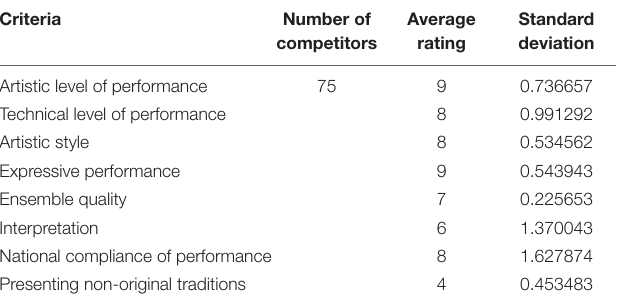
TABLE 4 | Analysis of vocal singing competition